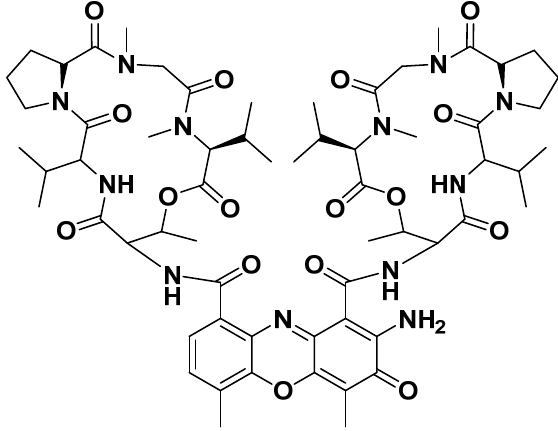
Figure 3. Chemical structure of actinomycin D.